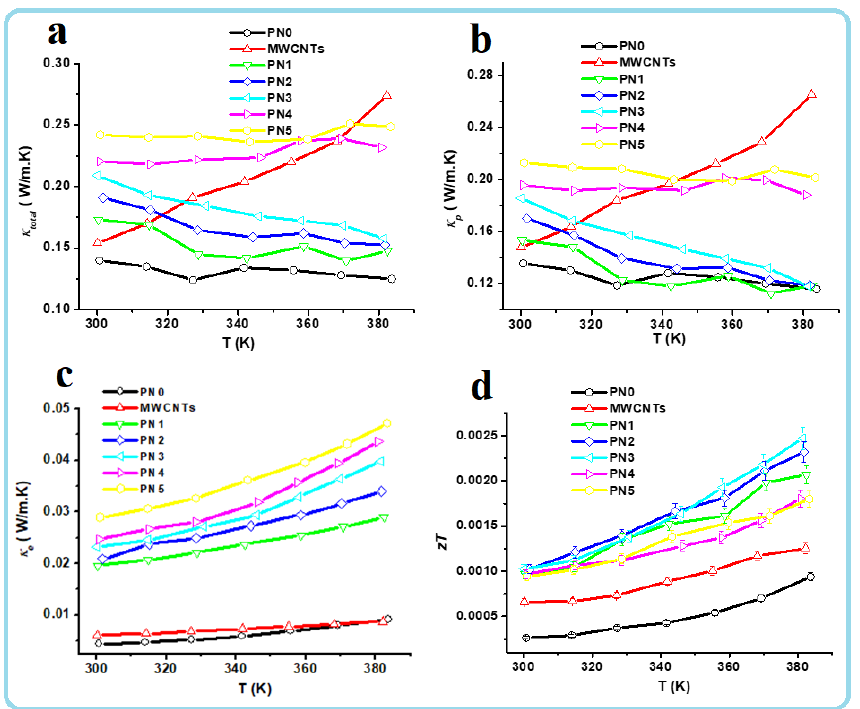
Figure 10. Total thermal conductivity, κ total ( a ), phonon thermal conductivity, κ p ( b ), electron thermal conductivity, κ e ( c ) and figure of merit, zT ( d ) of the MWCNTs/PPy nanocomposites as the functions of temperature.